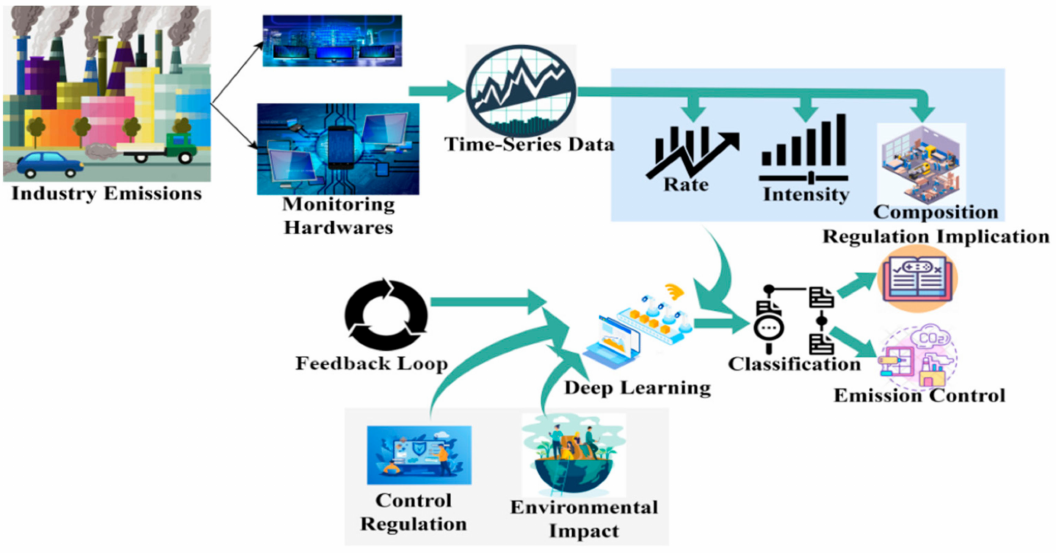
Figure 1. Working Process of Control-centric Data Classification